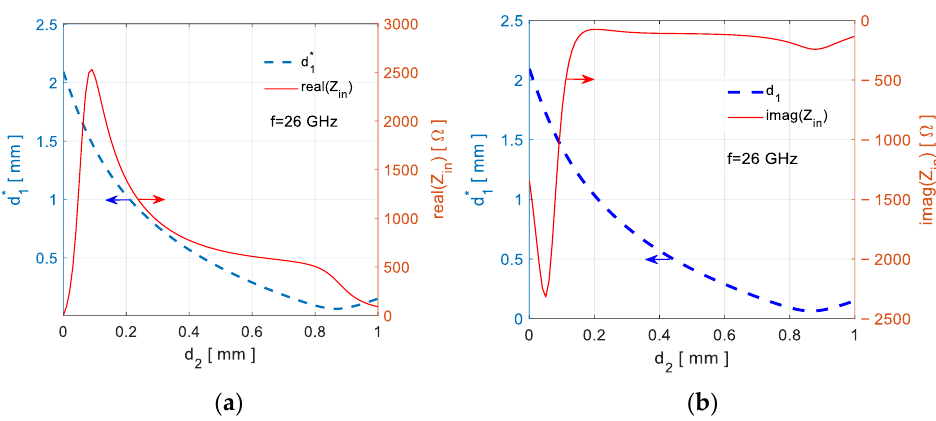
Figure 8. Real ( a ) and imaginary ( b ) parts of input impedance as function of d 1 *( d 2 ) at a frequency of 26 GHz.